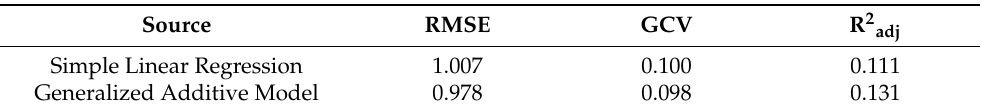
Table 4. Statistical fit by root mean square error (RMSE), generalized cross-validation (GCV), and adjusted R-square